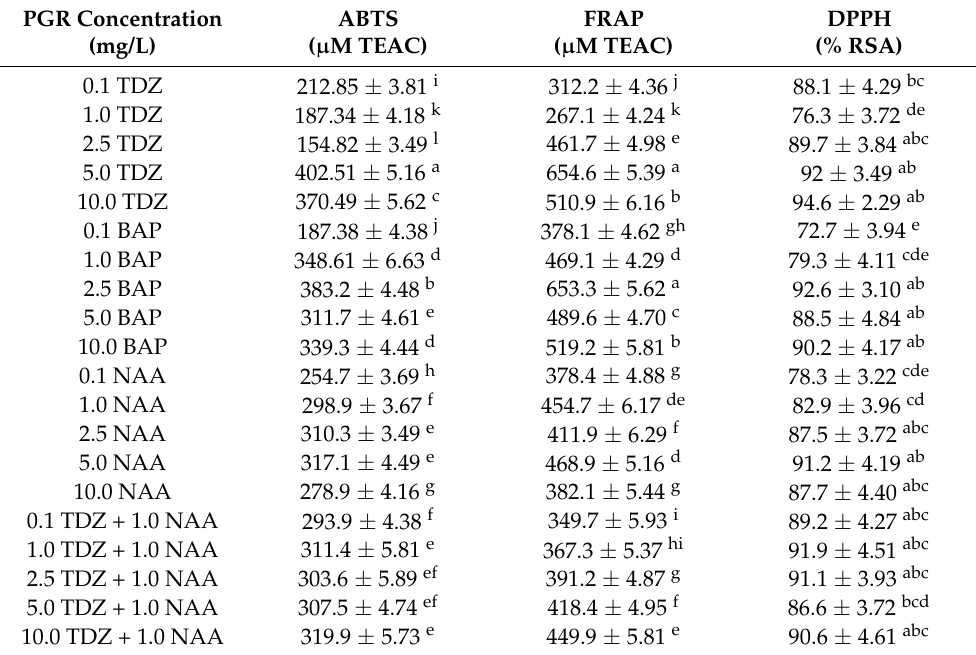
Table 4. Potential in vitro antioxidant (DPPH, FRAP, and ABTS) activities of the extracts of callus cultures of S. virginianum treated with different plant growth